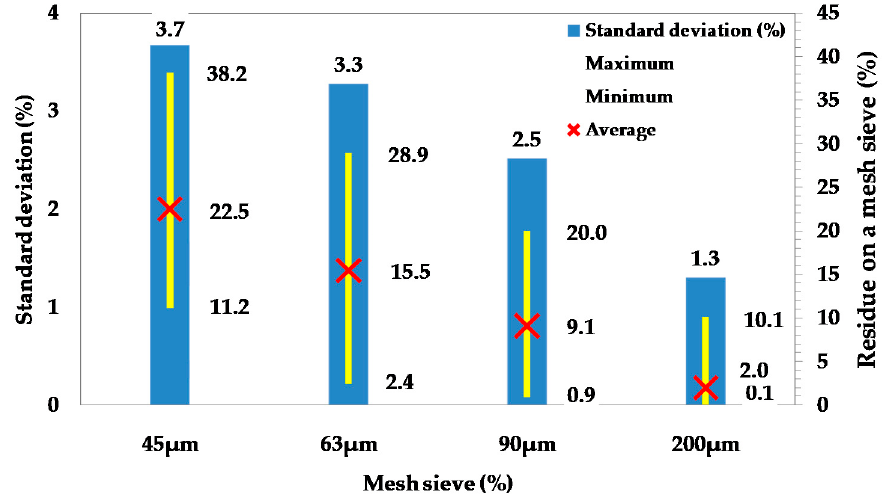
Figure 5. Maximum, average minimum and standard deviation results for the 45 µm, 63 µm, 90 µm and 200 µm sieve residues, calculated from 765 spot samples picked in a period of ten years. The relationship between the residues on the 45 µ m and 63 µ m mesh sieves, obtained Figure 6. A linear trend has been observed and represented with Equation (3). The slope of the regression line indicates that, on the average, one should expect an increase on the 63 µm mesh sieve of about 13% for every 20% increase on the 45 µm mesh sieve.